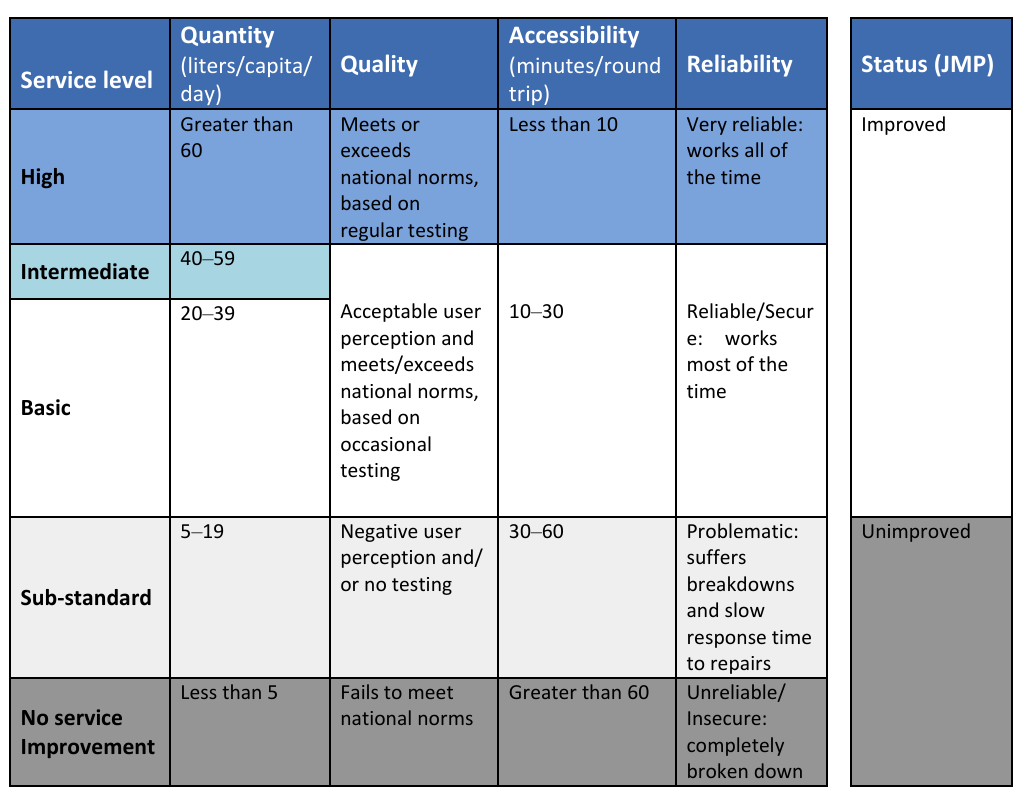
Figure 4. IRC water service delivery ladder framework (Adapted from [20,38] with